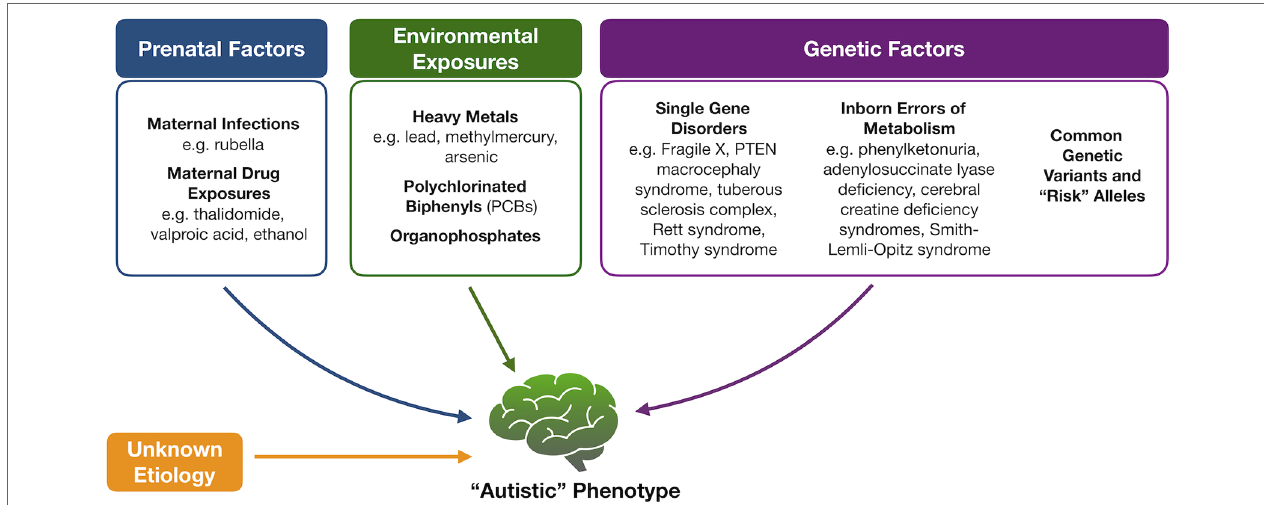
FIGURE 1 | Proposed etiologies for autism spectrum disorders. Multiple factors have been proposed to contribute to the development of autism spectrum disorder, including fetal exposures, childhood exposures, and underlying genetic causes that range from “risk” alleles to known Mendelian disorders and inborn errors of metabolism. In the majority of cases, however, an underlying etiology is not